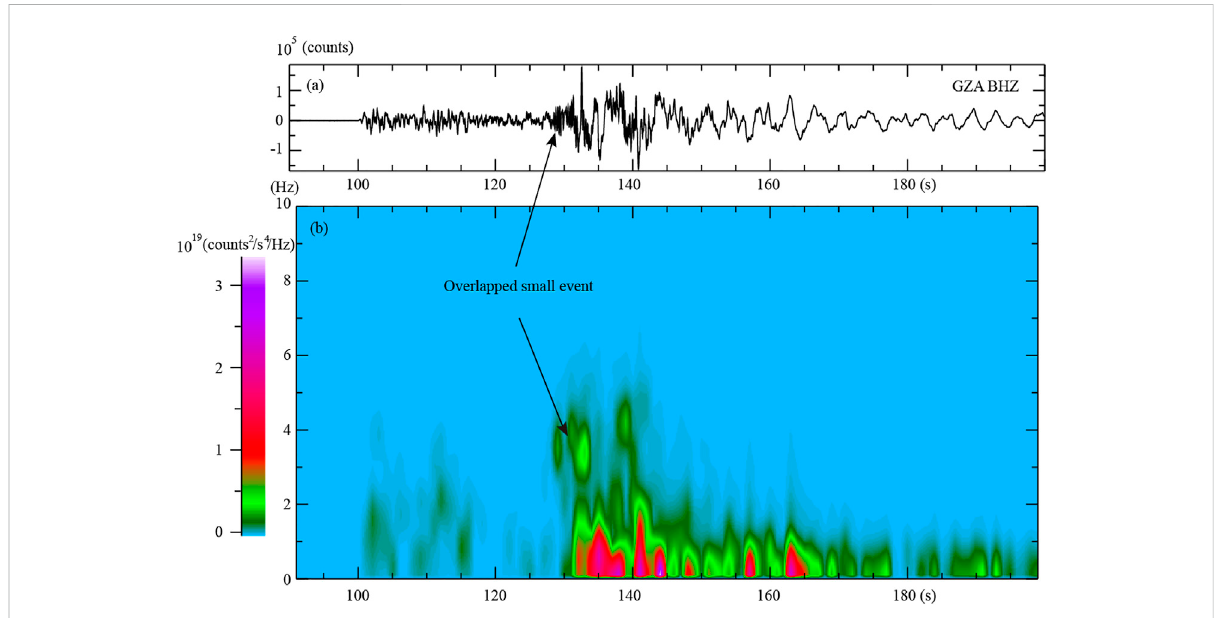
FIGURE 11 (A) Original waveform and (B) spectrogramofthe M s5.2 event, recorded atstation GZA, withthehigh-frequency energy signal detectedbefore the S phase indicating an overlapping small event.